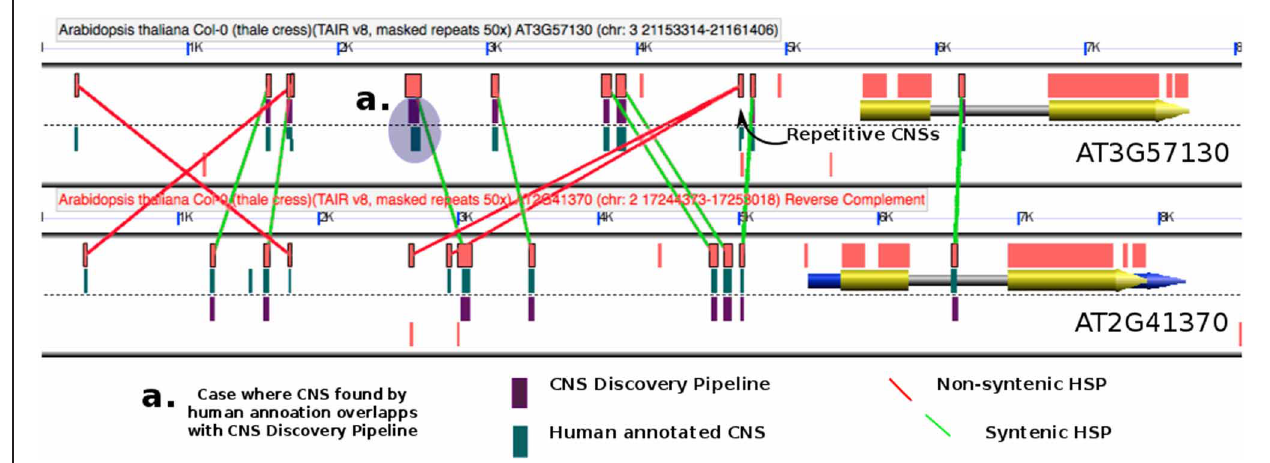
FIGURE 2 | Exemplary GEvo panel (Lyons and Freeling, 2008) depicting BlastN HSPs (orange rectangles) resulting from on-the-fly comparison of one particular homeologous gene pair in Arabidopsis thaliana . Coding exons are yellow while non-coding UTRs are blue. The TAIR8 genomes being used by GEvo is decorated by drawing purple rectangles for CNSs discovered by our Pipeline 3.0 (customized genome = dsid19494 available as a pull-down